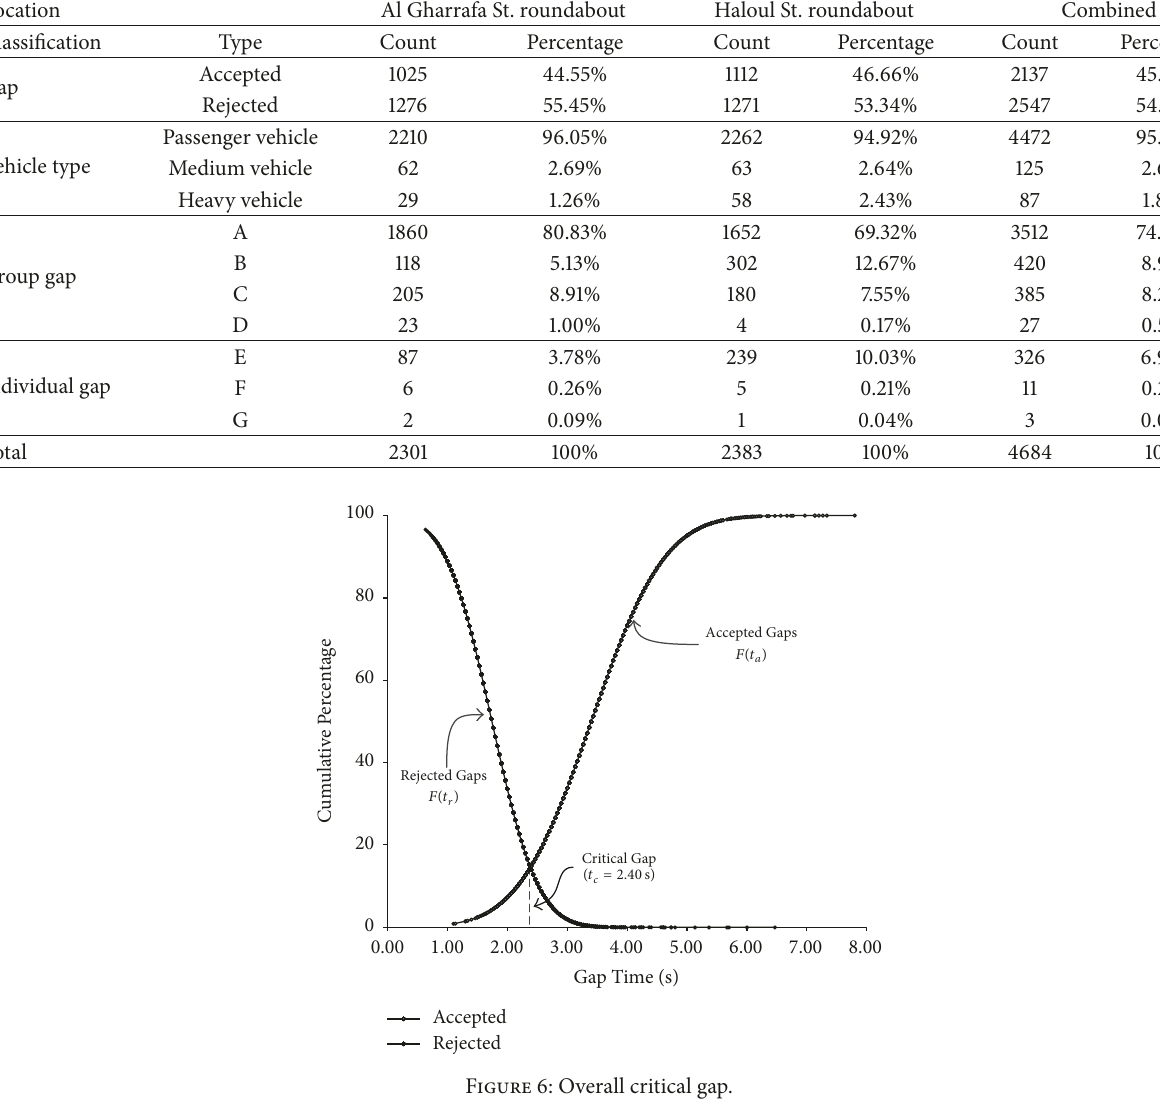
Table 2: Summary of data collected.